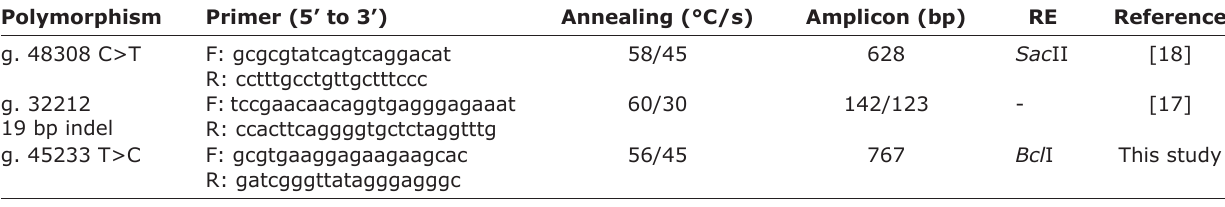
Table-1: Primer pairs of pleomorphic adenoma gene 1 used in this study.